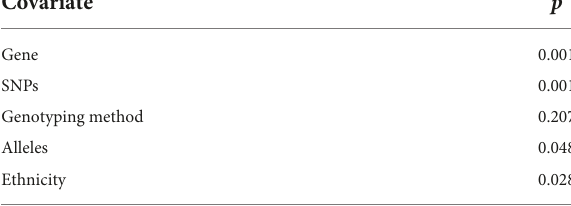
TABLE 2 Meta-regression based on genes, SNPs, genotyping method, and alleles as covariates of coronary artery disease.